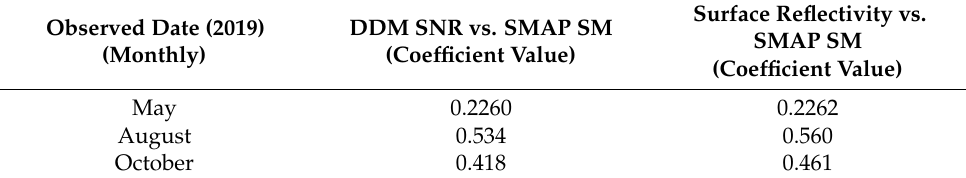
Table 2. CYGNSS and SMAP SM correlation in the Myanmar region.